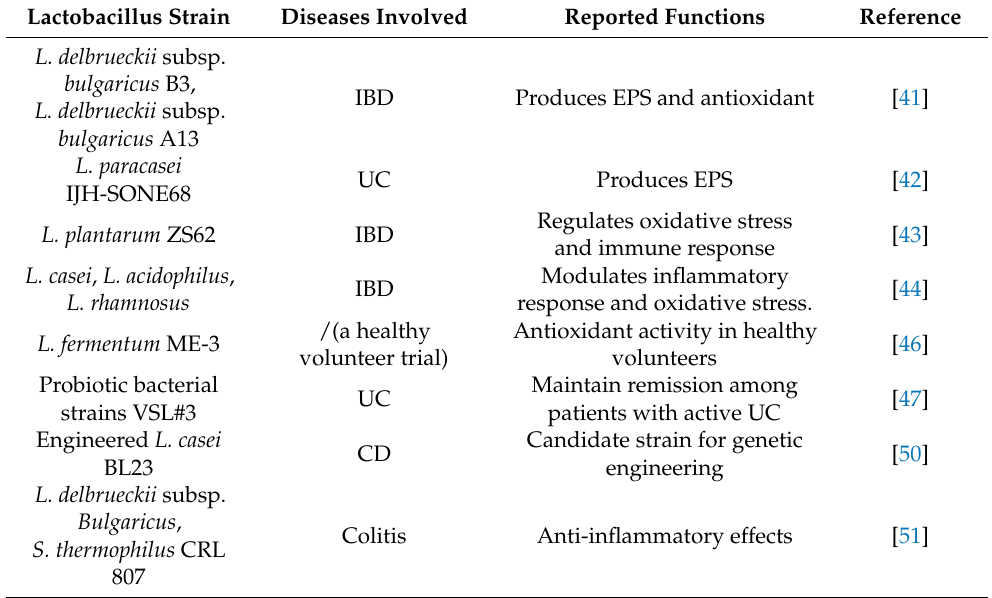
Table 1. Summary of the cited Lactobacillus strains and their function in